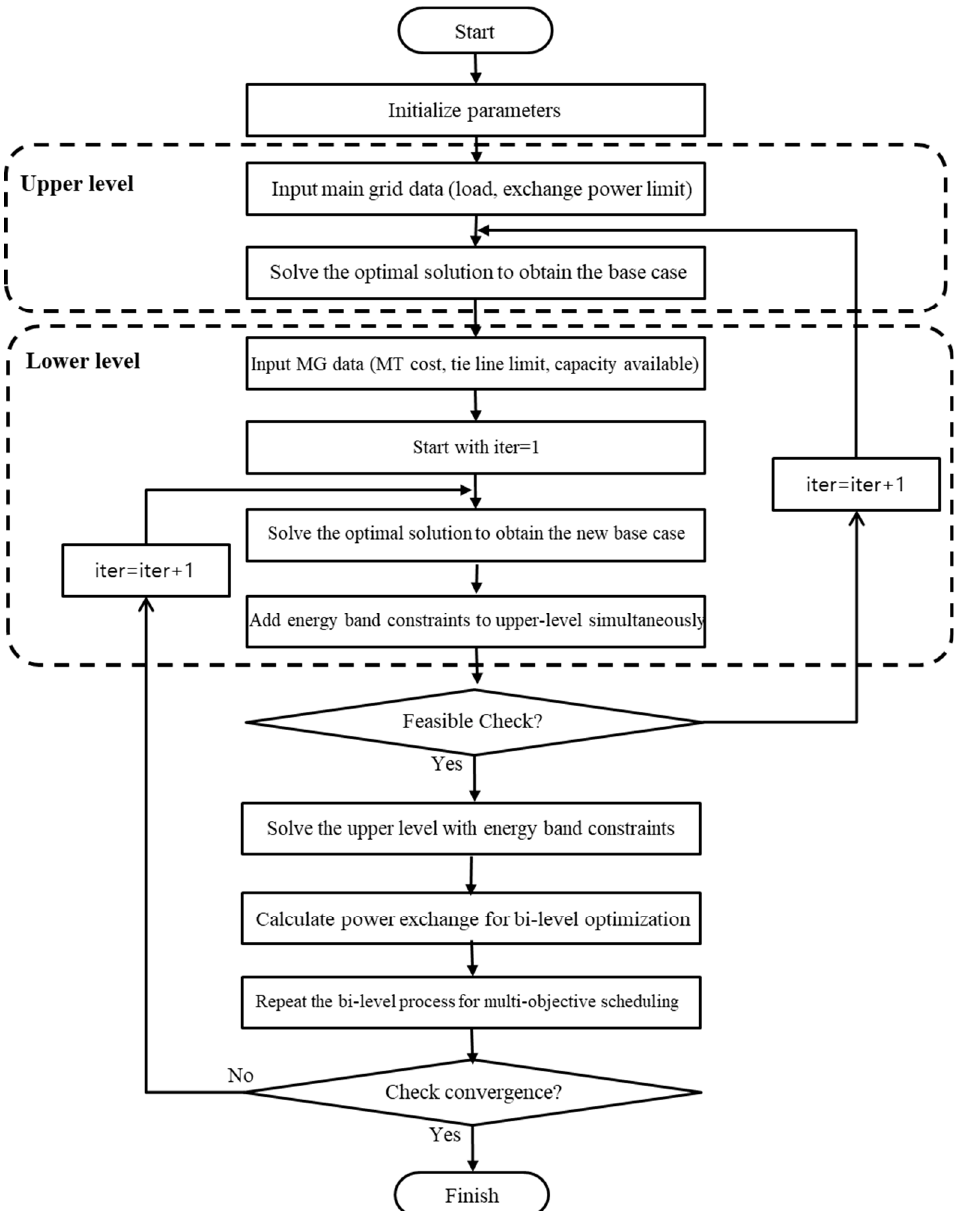
Figure 3. Bi-level optimization process.